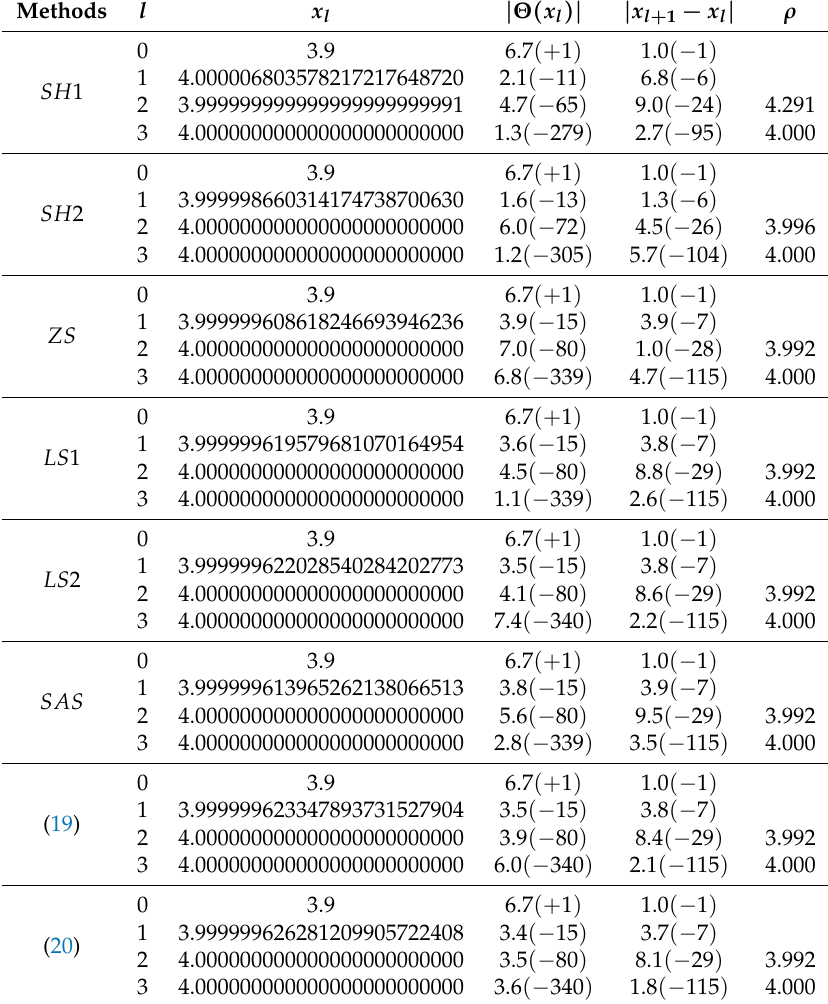
Table 2. Convergence study of distinct iterative functions on Θ 2 ( x )